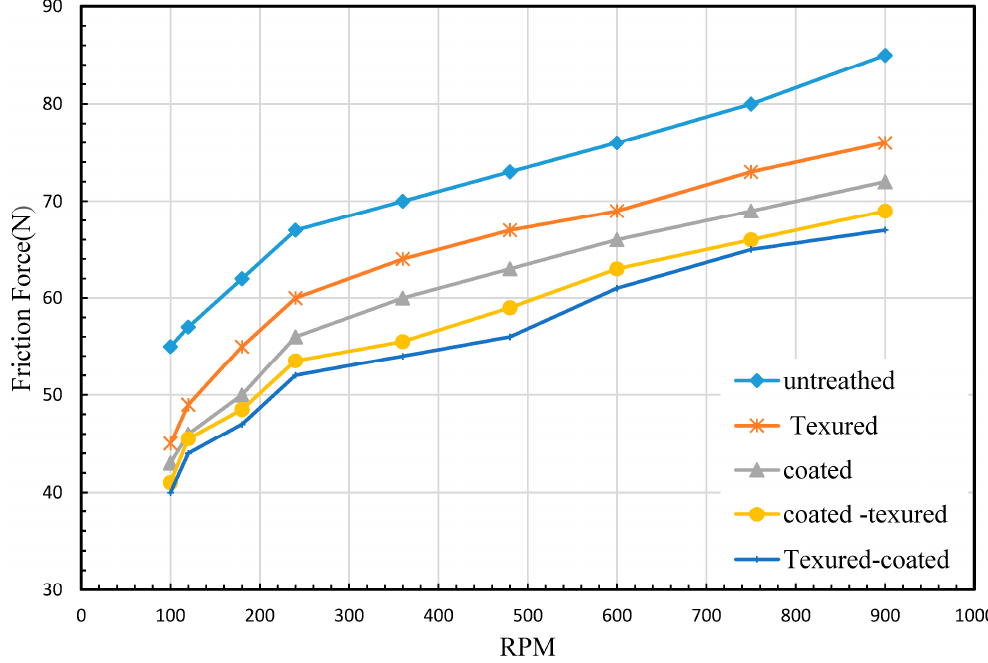
Figure 8. Frictional behavior of piston ring sets under after various surface treatments.